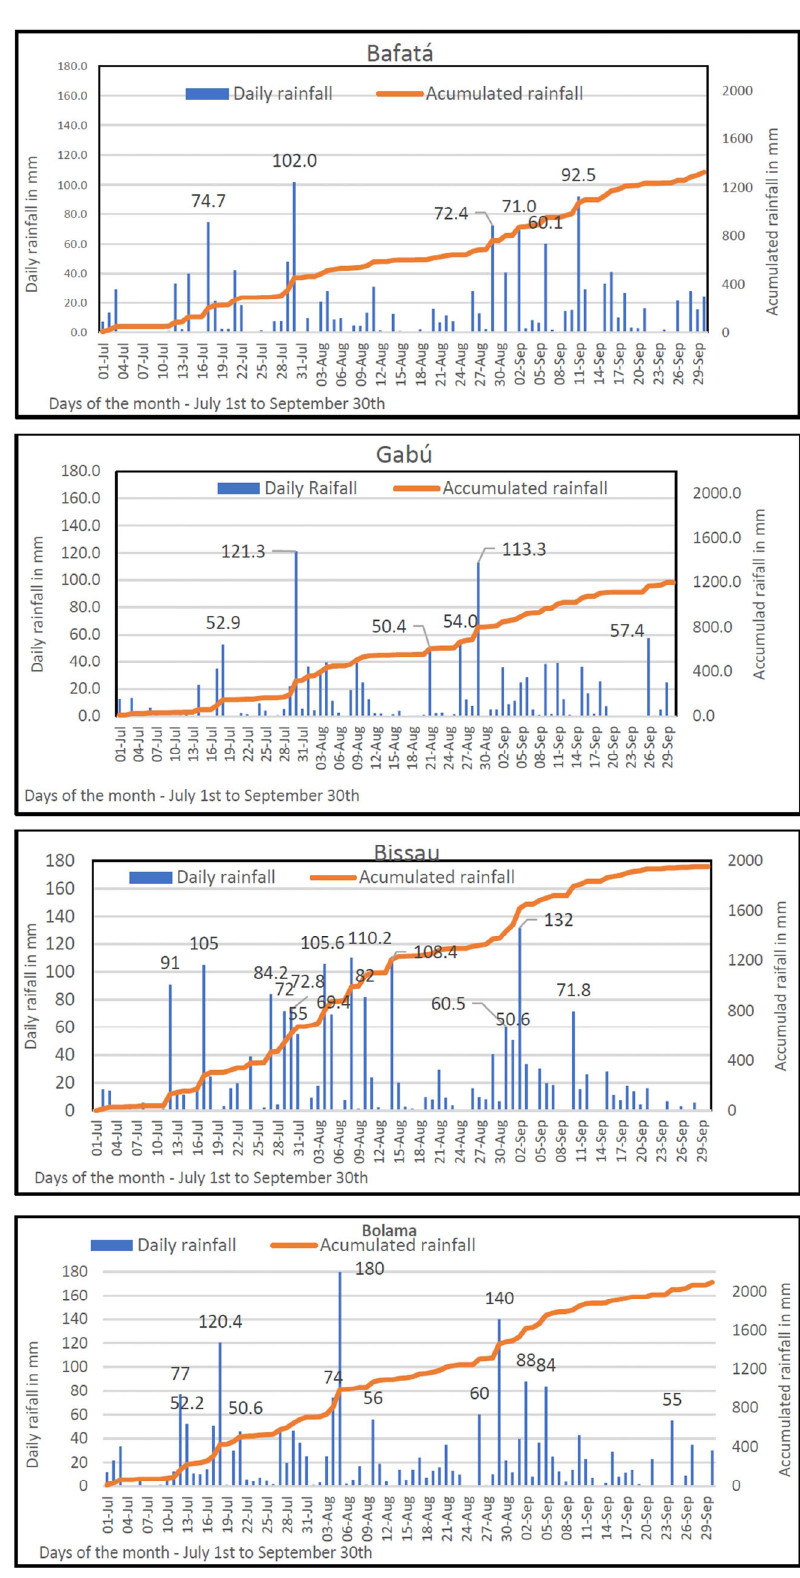
Figure 7. Daily rainfall in Bafatá, Gabú, Bissau, and Bolama from 1 June to 30 September 2020. Precipitation days with rainfall amounts above 50 mm are indicated.